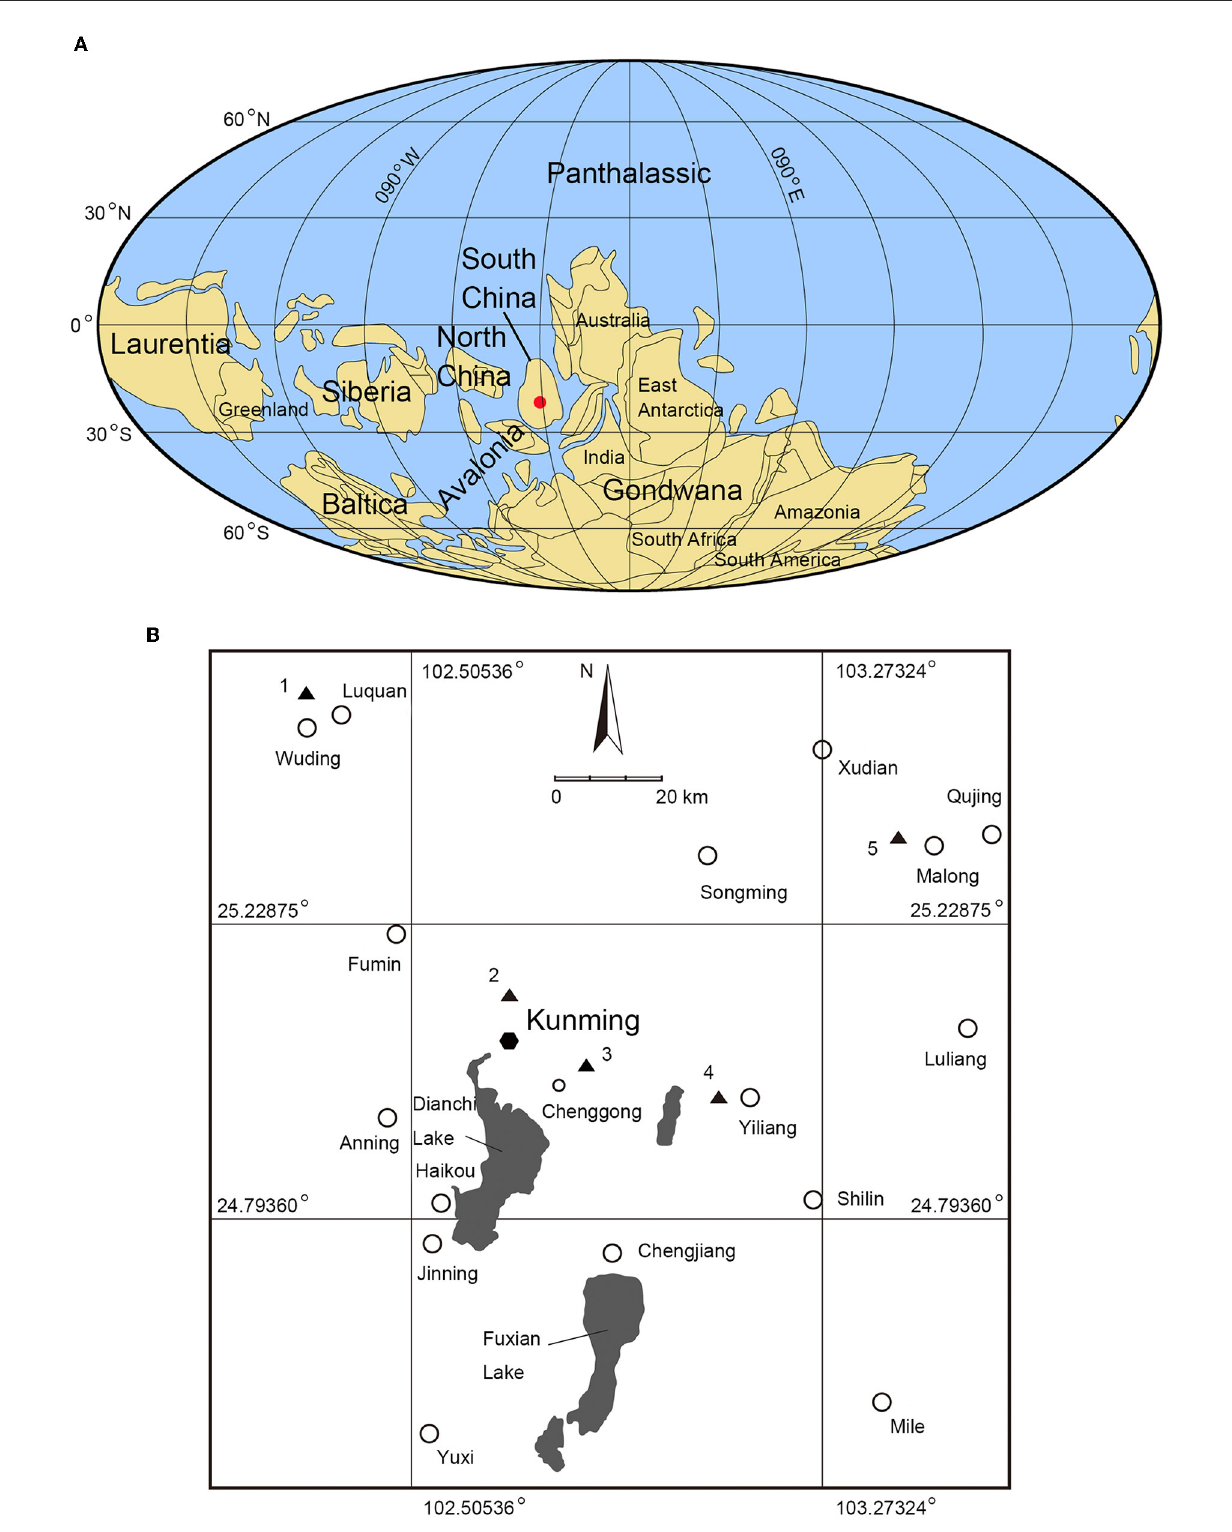
FIGURE1 Paleogeographic and geographic maps, showing the occurrence of Gaoloufangchaeta bifurcus gen. et sp. nov. (A) paleogeographic reconstruction in early and middle Cambrian, modified from Torsvik and Cocks (2017); (B) the main fossil sites of the Guanshan biota in eastern Yunnan. 1, Shijiangjun; 2, Gangtoucun; 3, Gaoloufang; 4, Lihuazhang; 5,